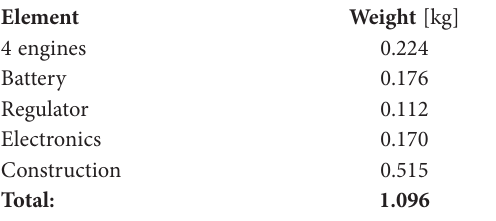
Table. Weight of basic quadrocopter elements